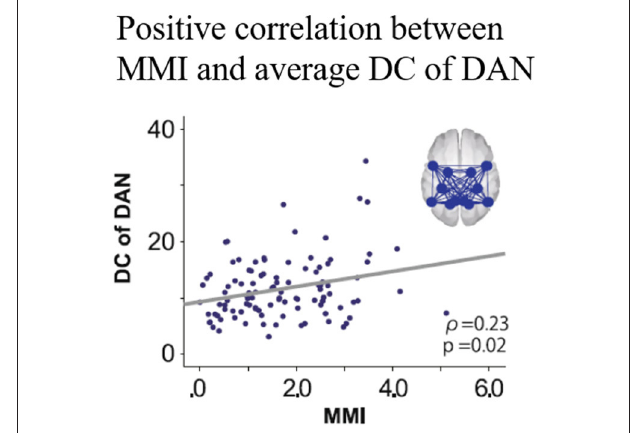
FIGURE 4 | Time-course changes of the DCs for the resting state and oddball task phase. Each dot indicates the DC values for each participant. A significant decrease was found in the DCs from the resting state to the oddball task phase, as calculated using paired t -tests ( t = 4.56, p < 0.01). DC, degree centrality [Revised from Kobayashi et al. ( 39)].